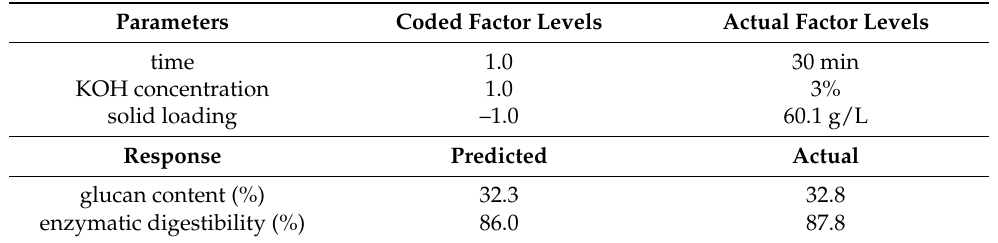
Table 6. Numerical optimization and validation of pretreatment based on the regression